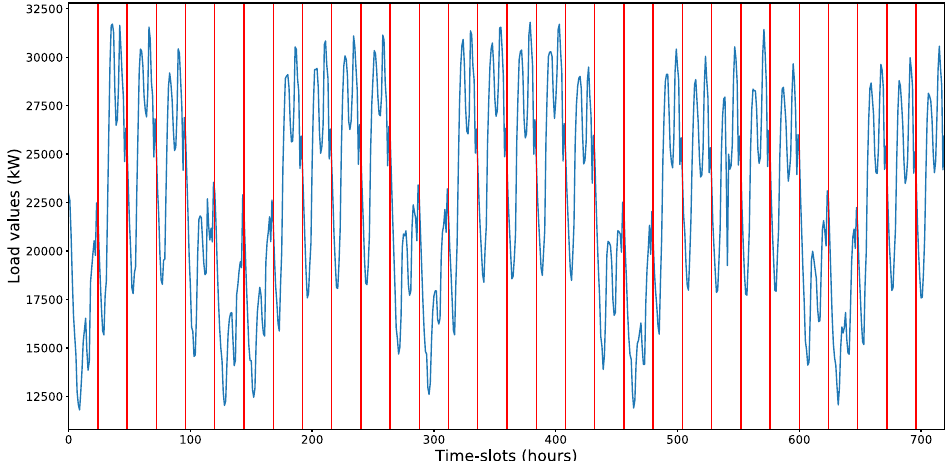
Figure 1. Chart showing the load values for a period of 30 days and time-slots of 1 h. The vertical red lines indicate a 24 h period (1 day). We can observe the strong daily and weekly periodicity. Load values were aggregated in time-slots of one hour. The total number of time-